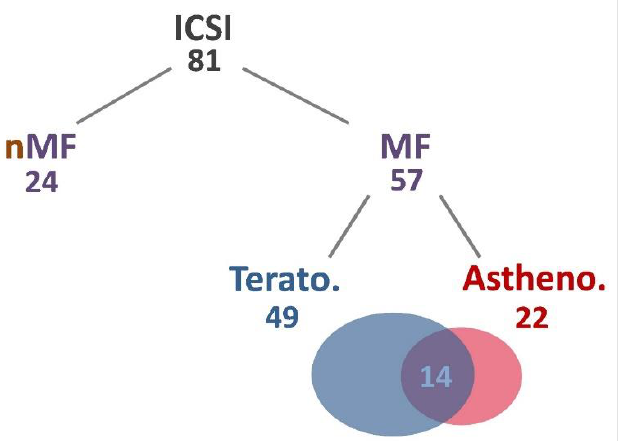
Figure 1. Distribution of sperm samples. Numbers indicate the number of cases. Abbreviations: Astheno, asthenozoospermia; ICSI, intracytoplasmic sperm injection; MF, male factor; nMF, non-male factor; Terato, teratozoospermia.